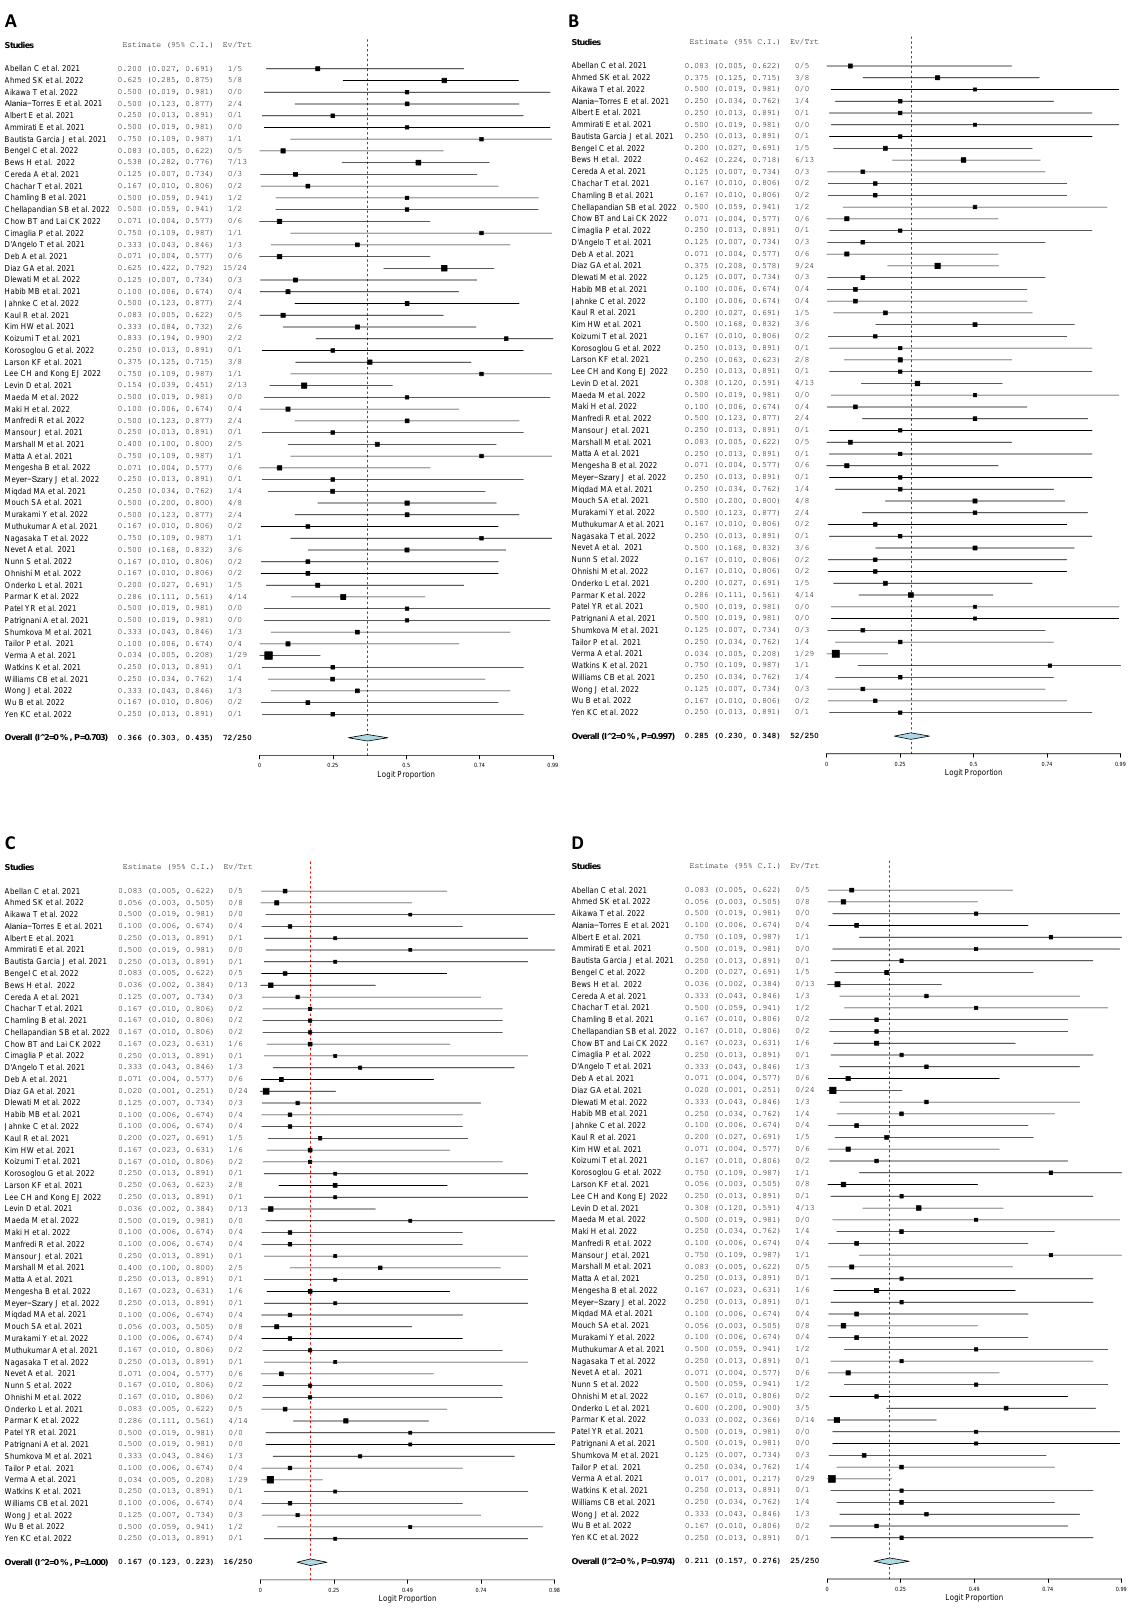
Figure 4. Forest plot of treatment modality. ( A ) NSAID. ( B ) Colchicine. ( C ) Steroids. ( D ) Beta- blocker.